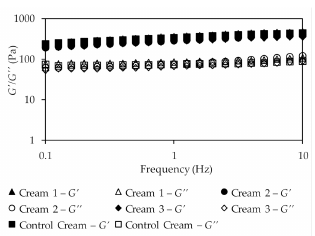
Figure 5. Results of the oscillatory frequency sweep test for the different